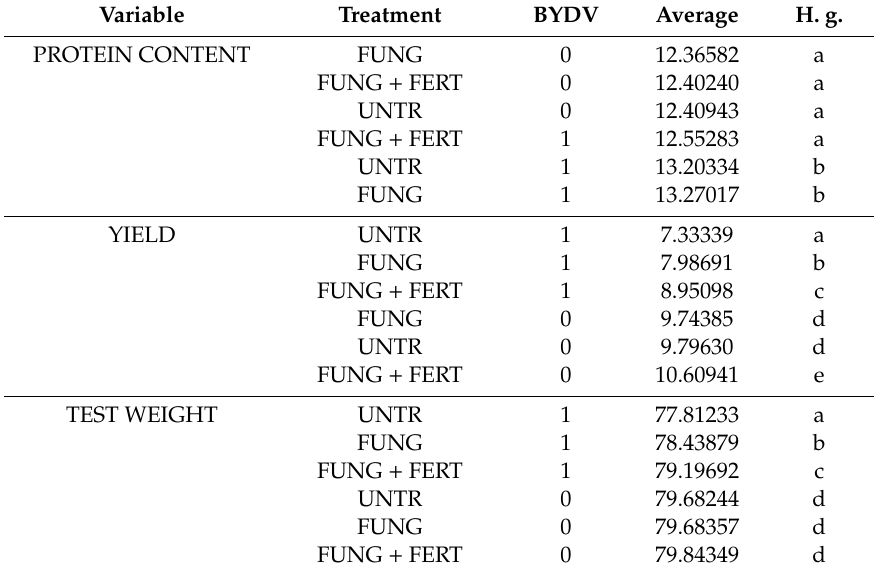
Table 5. E ff ects of treatment on protein content, grain yield, and test weight in infected and uninfected variants with